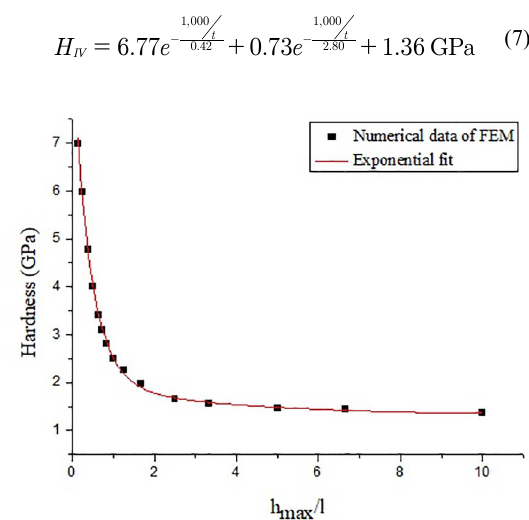
Figure 5. Numerical results for Vickers indentation hardness as a function of h / l for the Ti / TiN system considering a 1,000 nm max penetration depth. Table 5. Exponential power curve parameters for numerical hardness behavior as a function of ratio h / t . max Constants